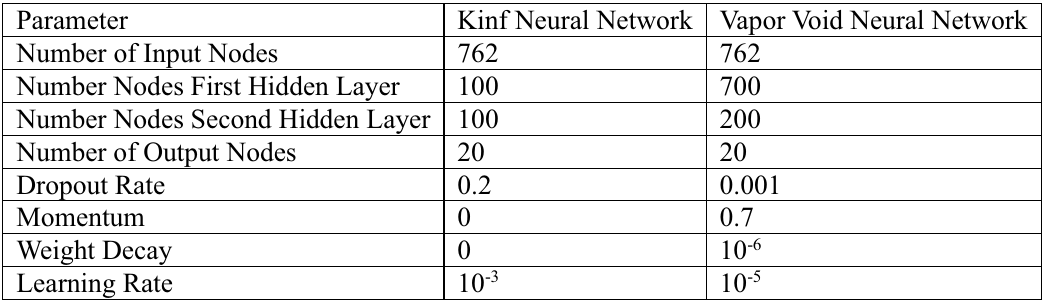
Table II. ANN Architecture: Parameters used in training the two neural networks used in the optimization.